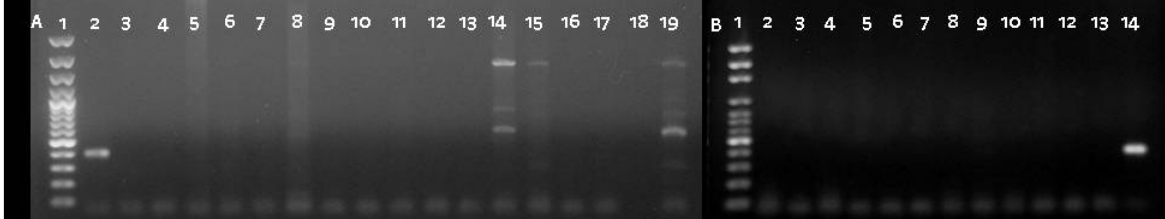
Figure 2. A) Specificity of CLO1F/CLO1R primer pair. Lanes 1–19, 100 bp DNA Marker, C. luteo-olivacea, E.